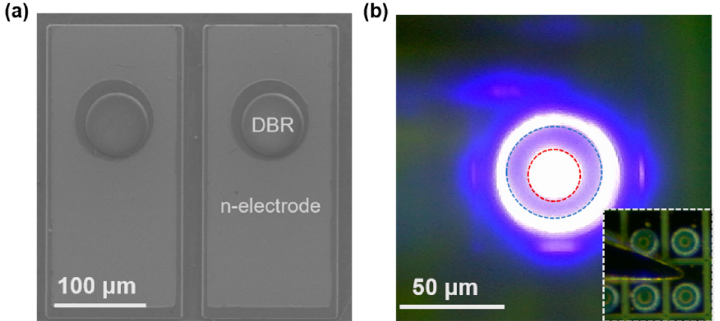
Figure 5. ( a ) Top-view SEM and ( b ) light-up images of the as-fabricated GaN-based RCLED with a diameter of 20 μ m. In ( b ), the injection current was 2 mA, and the red and blue circles show the sizes of the current aperture and the n-side DBR, respectively. The inset shows the optical microscopy image of the RCLED.